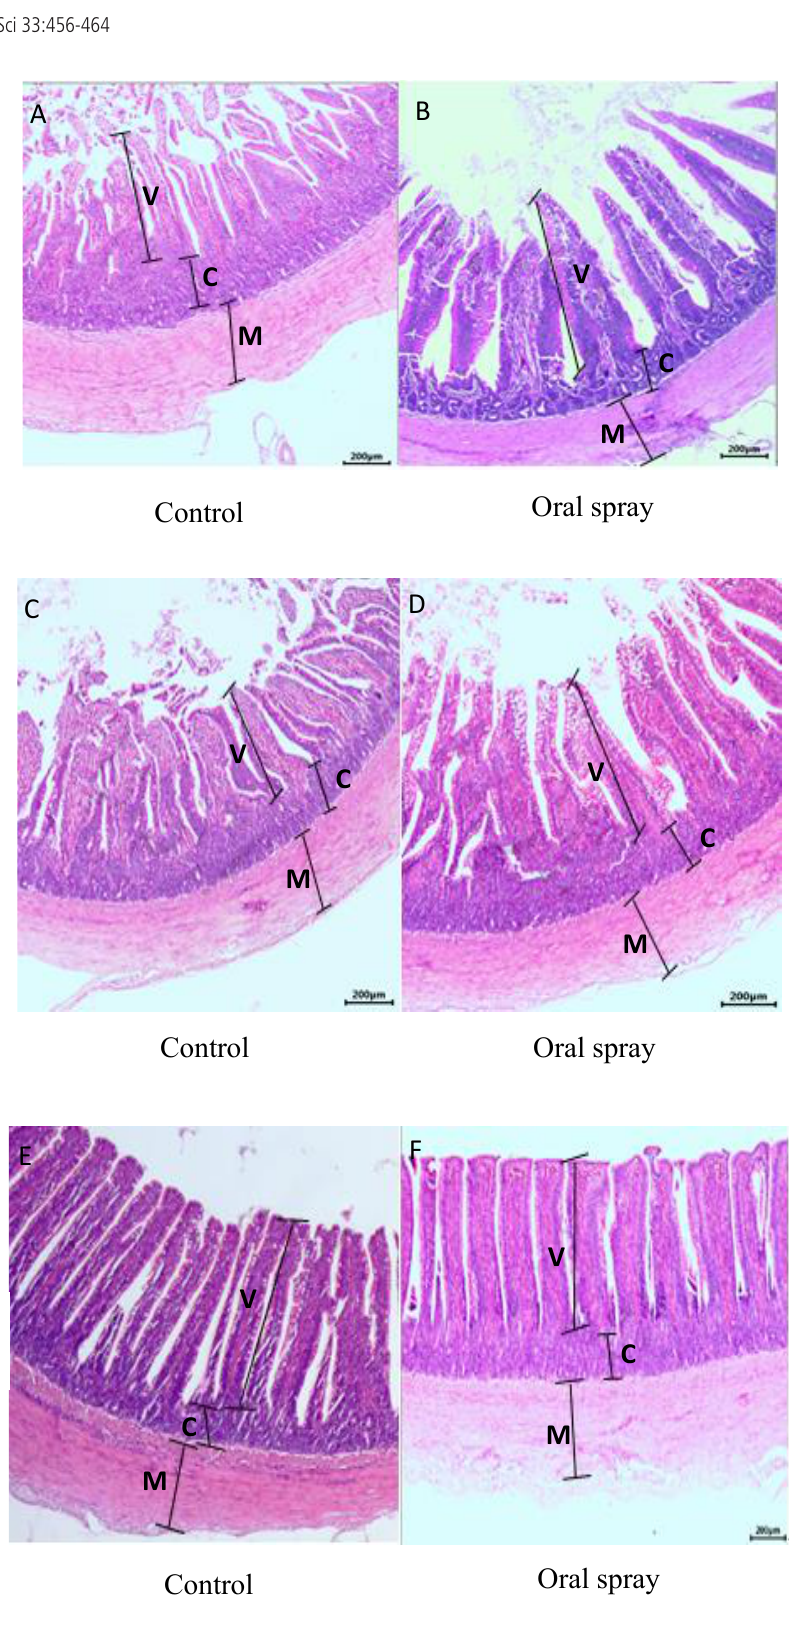
Figure 3. Representative light microscopy (×200) of the histomorphology of duodenum (A, B), jejunum (C, D) and ileum (E, F) of the ducklings at 21 d of age. V, villus; C, crypt; M, muscularis mucosa; control group, the basal diet supplemented with Lactobacillus fermentation; oral spray group, ducklings fed the basal diet and administrated Lactobacillus fermentation by oral spray way.